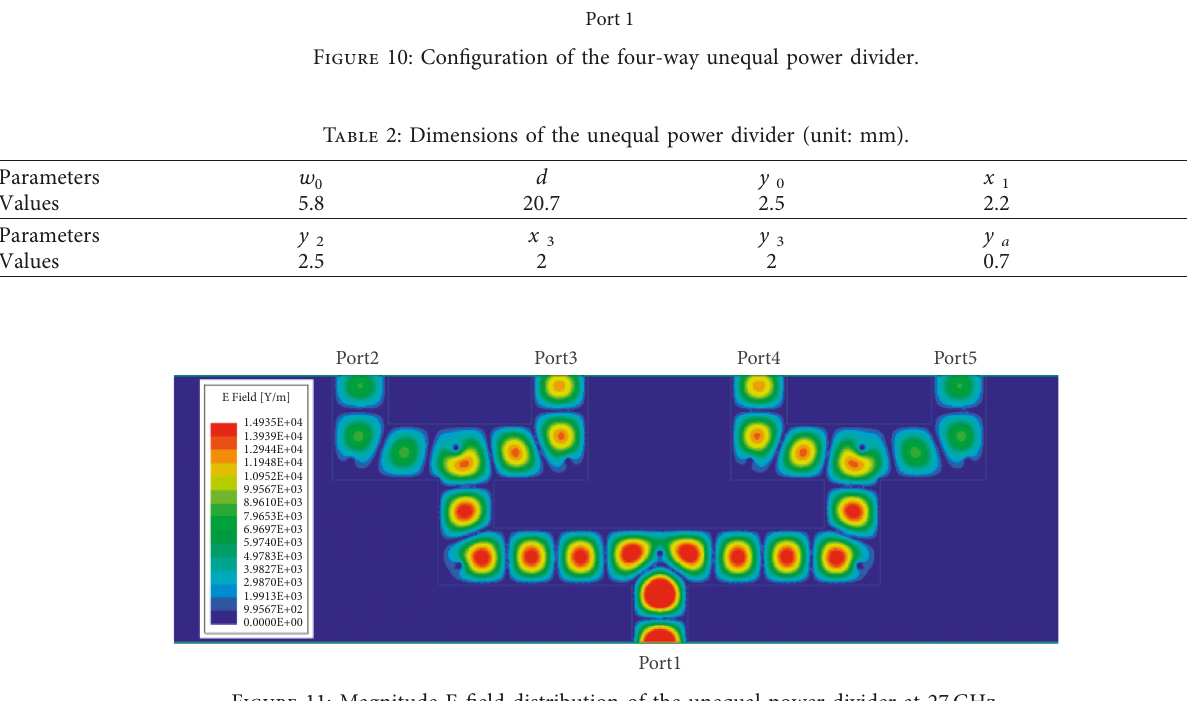
Figure 11: Magnitude E-field distribution of the unequal power divider at 27 GHz.